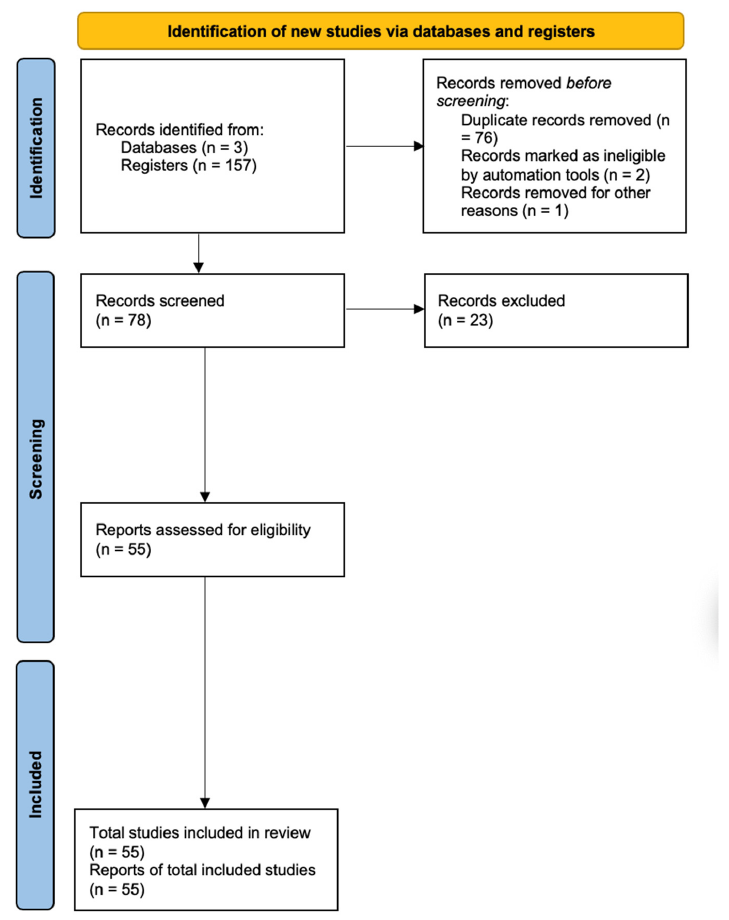
Figure 3. PRISMA flow diagram of search strategy conducted in the systematic review.